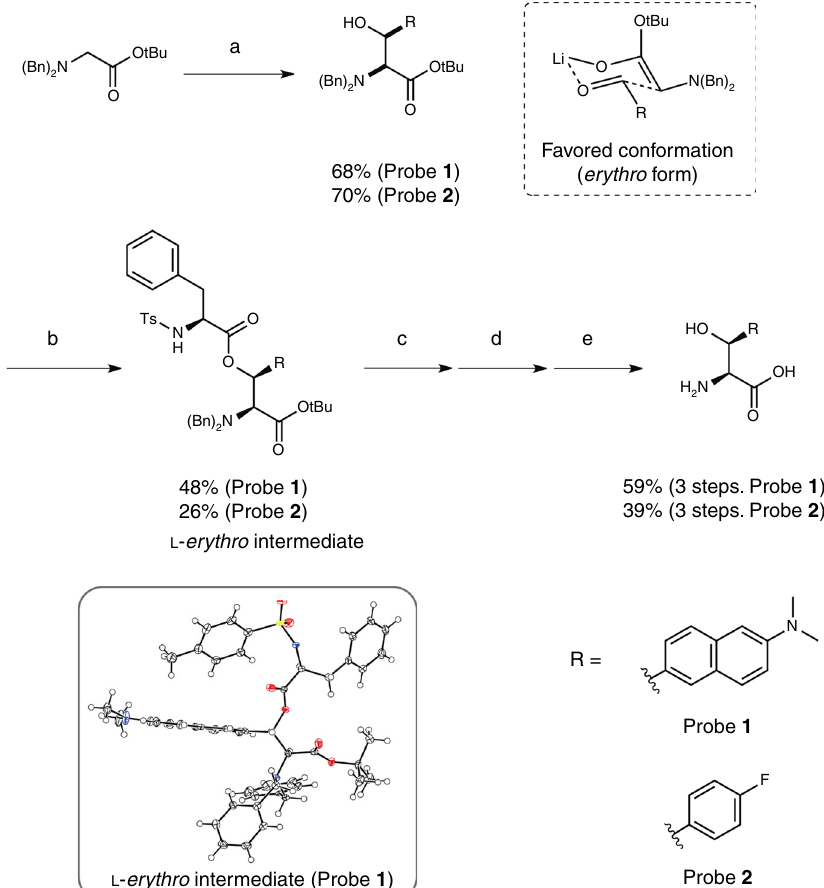
Fig. 3 Synthesis of hSHMT fl uorescent probe 1 and NMR probe 2 . Reagents and conditions for synthesis of probe 1 : a) N -Dibenzylglycine tert -butyl ester, LDA, dry THF, – 60 °C, 10 min, then 6-(dimethylamino)-2-naphthaldehyde, – 60 °C, 30 min; b) N -( p -Toluenesulfonyl)- L -phenylalanyl chloride, DMAP, dry THF, r.t., 14 h; c) 5 M NaOH aq., THF, EtOH, r.t., 5 min; d) Pd/C, H 2 , MeOH, r.t., 28 h; e) 4 M HCl/EtOAc, r.t. reagents and conditions for synthesis of